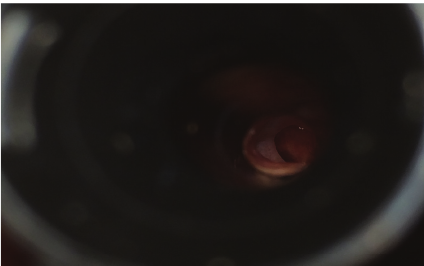
Figure 1: Microscopic view of the right ear, showing a clean central perforation of the tympanic membrane after the removal of the larvae.